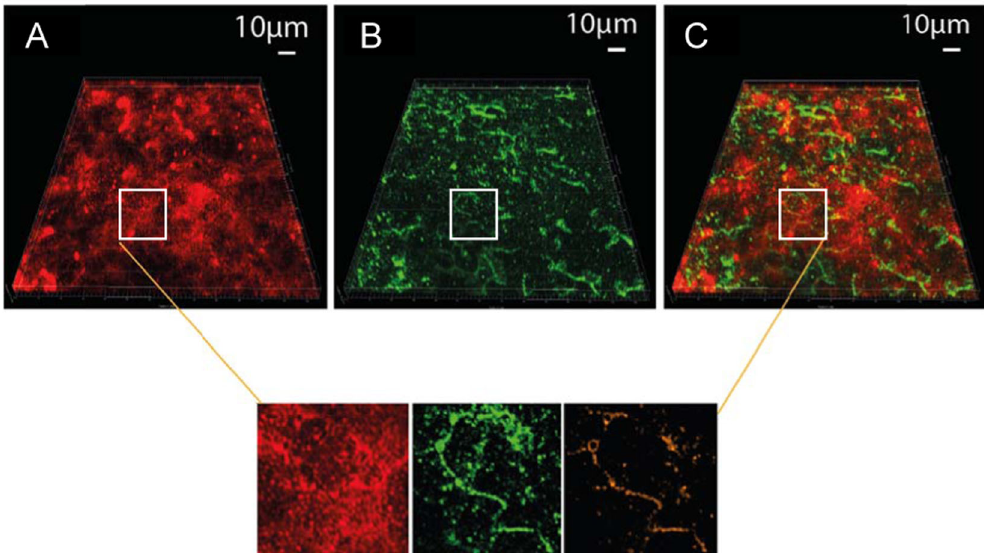
Fig. 6 G-quadruplex DNA present in static and fl ow-cell P. aeruginosa bio fi lms. Three-dimensional (3-D) confocal micrographs of 3-day P. aeruginosa wild-type fl ow-cell bio fi lm showing the colocalisation of eDNA and G-quadruplex nucleic acid structures in the matrix of the bio fi lm, as illustrated by binding to DNA-speci fi c dye propidium iodide (PI; red), ( A ) the binding of anti-DNA G-quadruplex structure antibody to the eDNA fi bres, visualised with GFP-labelled goat anti-mouse IgG (green) ( B ) and overlapping binding of both PI and anti-DNA G- quadruplex antibody ( C ). The zoomed-in insets from the three images showing a region of colocalisation of G-quadruplex antibody with